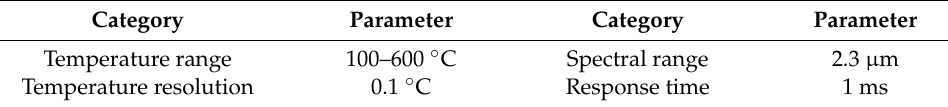
Table 3. Thermometer technical parameters.